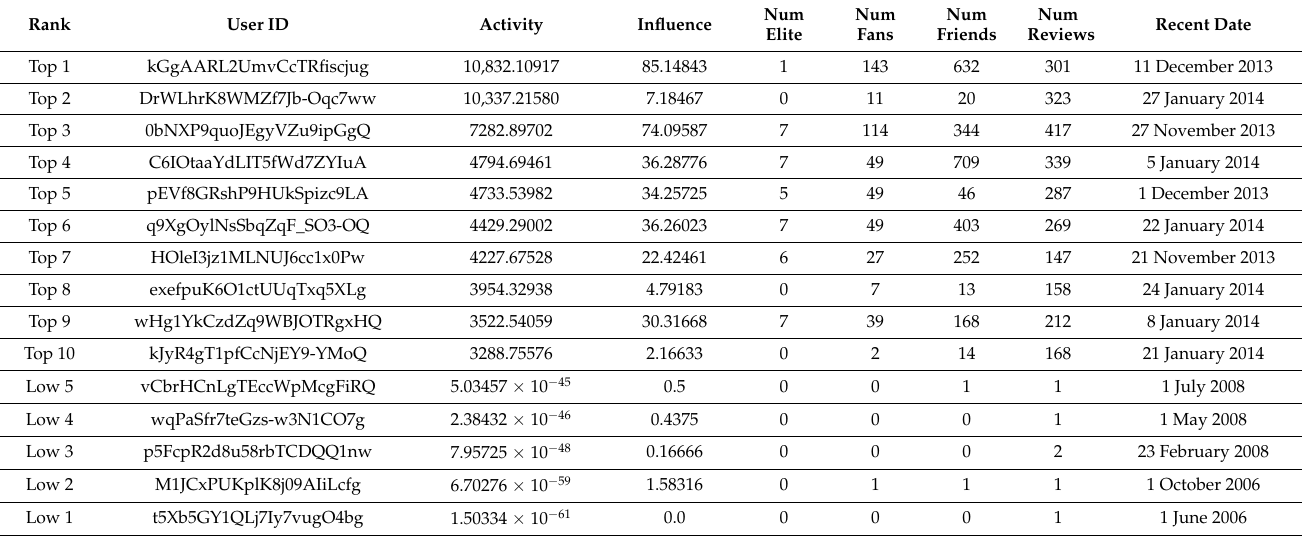
Figure 4. Evaluation difference between top 10 influential users and the average of all users: ( a ) the difference is shown for each restaurant; ( b ) the average evaluation difference is shown for each of the top 10 influential users. Table 3. Top 10 and lowest 5 active user